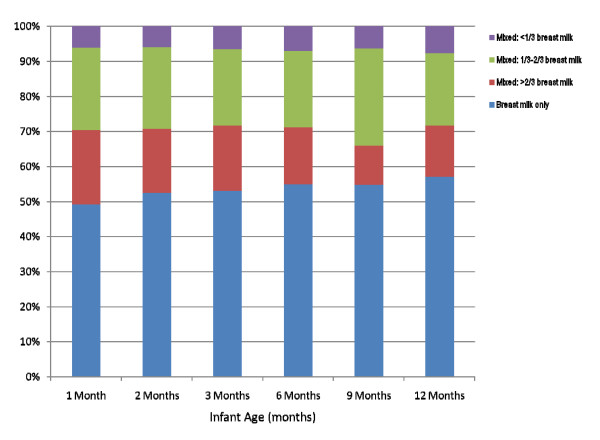
The proportion of milk and formula feedings among breastfeeding mothers across the first year of life. Data refers only to the milk-based infant diet and therefore after 6 months of age would also include the feeding of complementary foods along with breastmilk and infant formula. Legend: Sample sizes were as follows: 1 month, n = 834; 2 months, n = 615; 3 months, n = 494, 6 months, n = 354; 9 months, n = 249; 12 months, n = 165.